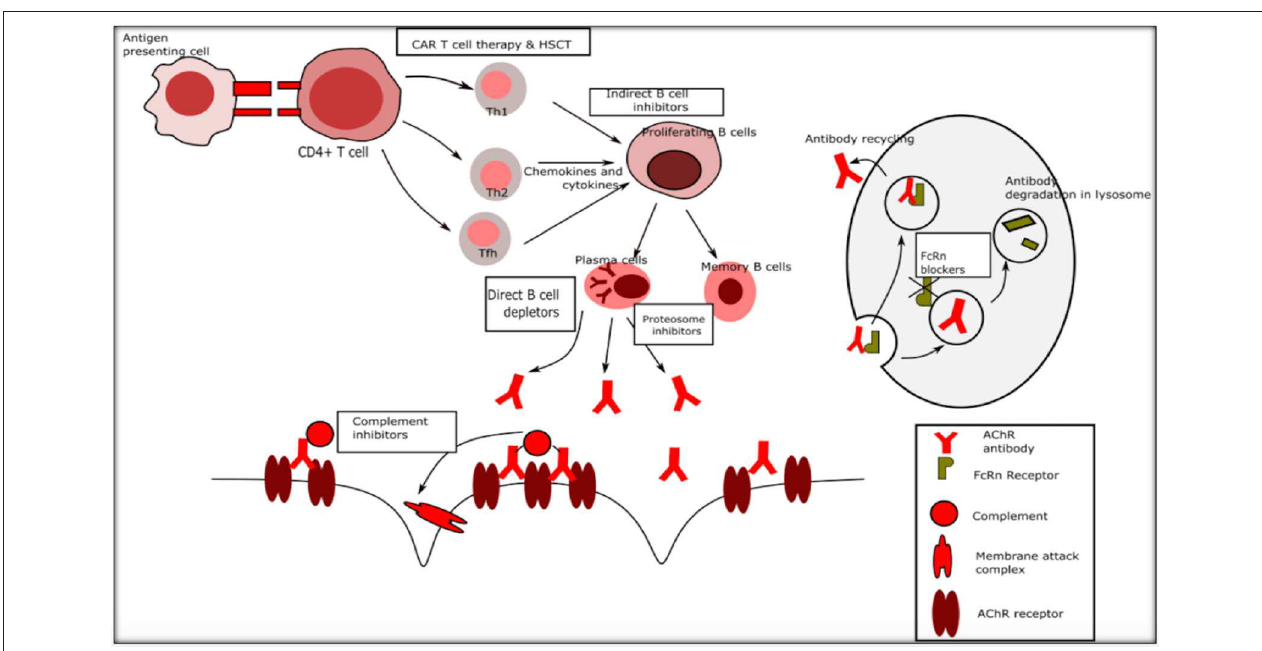
FIGURE 1 | Immune targets for novel therapies in myasthenia gravis. Th1 Type 1 T helper cells, Th2 Type 2 T helper